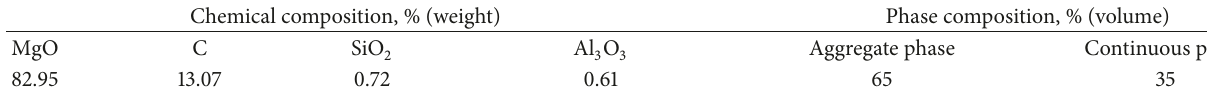
Table 1: The composition of magnesia carbon refractory.